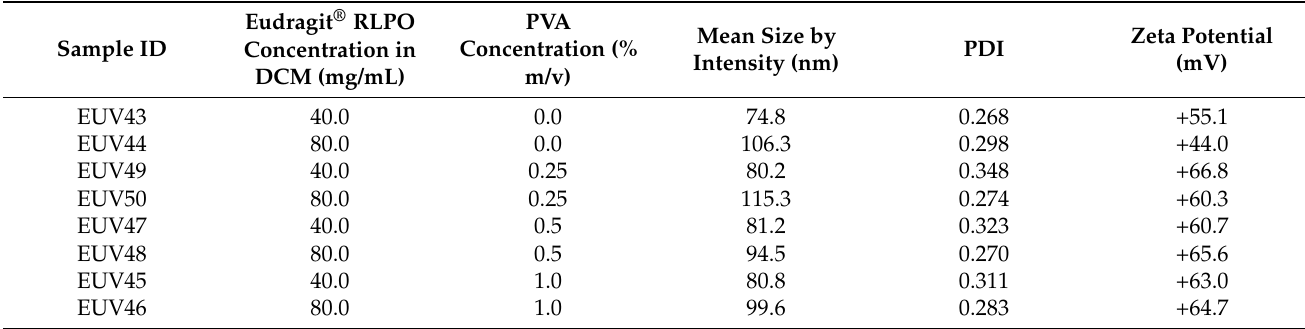
Table 2. Experimental parameters of blank Eudragit ® RLPO nanoparticles prepared by single-emulsion–solvent evaporation method and the measured average particle sizes, polydispersity indices, and zeta potential values.